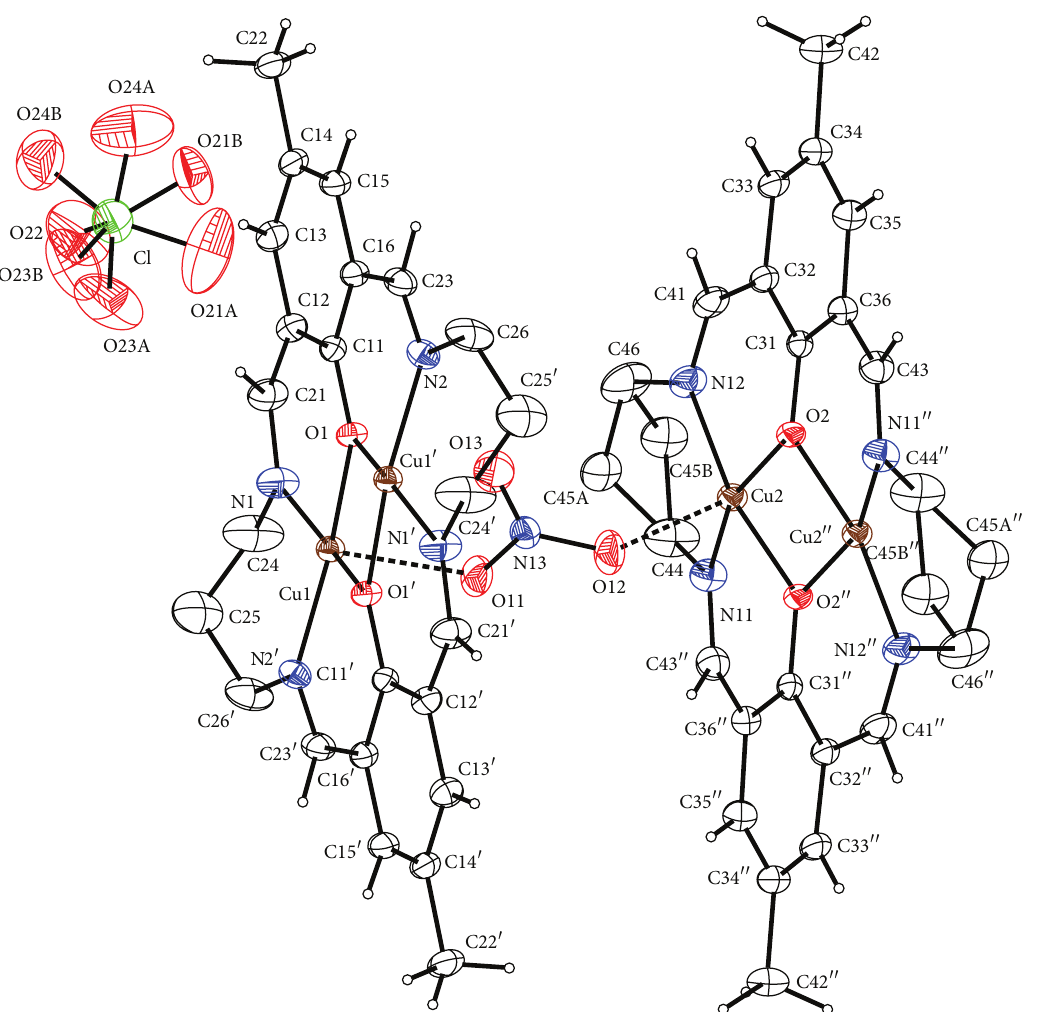
Figure 1: The molecular structure of [ { Cu 2 (tidf)( 𝜇 -NO 3 ) } ∞ ]ClO 4 showing the atom-labeling scheme. Displacement ellipsoids drawn at the 30% probability level. H atoms of methylene groups omitted for clarity [symmetry codes ( 󸀠 ): −𝑥 , 2 − 𝑦 , and 1 − 𝑧 ; ( 󸀠󸀠 ): 1 − 𝑥 , 2 − 𝑦 , and 2 − 𝑧